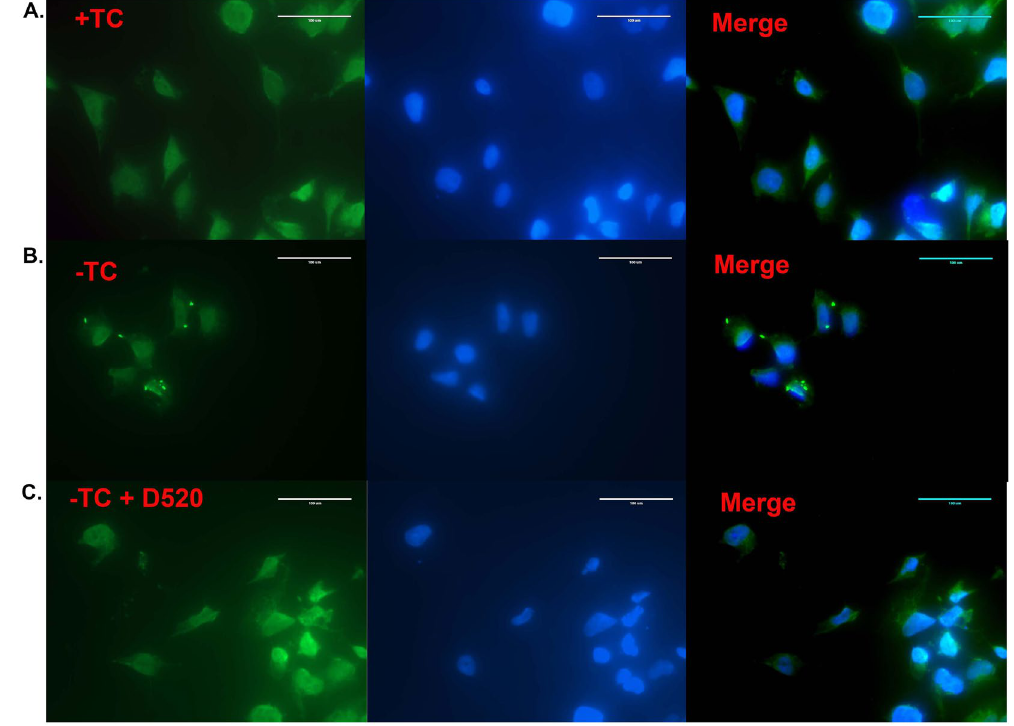
Figure 7. D-520 blocks the appearance of A β oligomers in MC65 cells: Immunocytochemistry of MC65 cells from treatment with D-520: MC65 cells were treated with the D-520 at a concentration of 20 μ M immediately after the removal of Tetracycline from the media. 48 h after the treatments, cells were fixed and immune fluorescently labeled with A β specific antibody (Green) and counter stained with DAPI for nuclear staining. Panel A: control shows the dispersed expression of A β . When Tetracycline is removed from the media, it leads to the formation of A β oligomers seen as punctate structures with intense green staining (Panel B). However, when the cells are treated with D-520, it leads to the decrease in the A β oligomer formation as seen by the even fluorescence throughout the cells (Panel